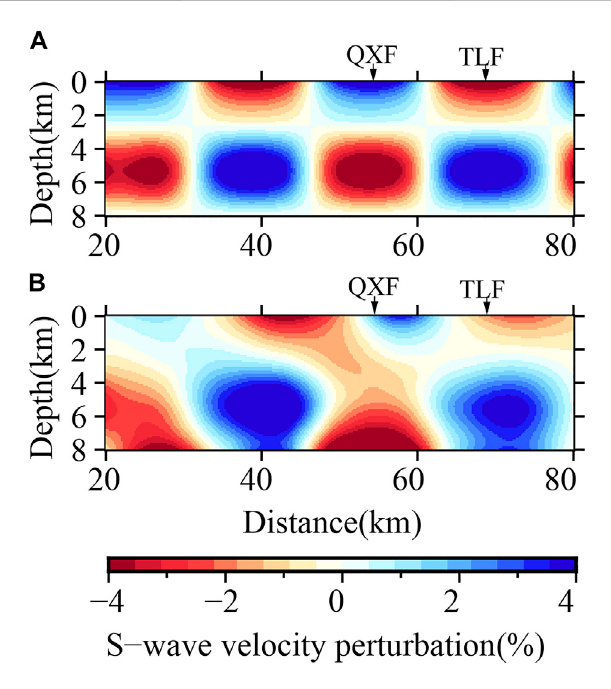
FIGURE 6 TheoreticalresultsofcheckerboardtestinverticalslicesXX ’ (shown in Figure 2; (A) : Real model; (B) : Inverted